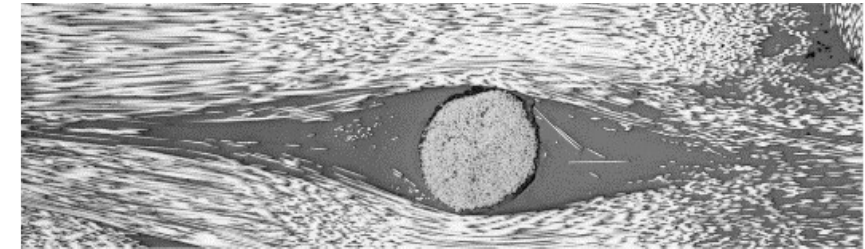
Figure 6. Debonding of a fibrous z-Pin due to residual stresses in the host composite